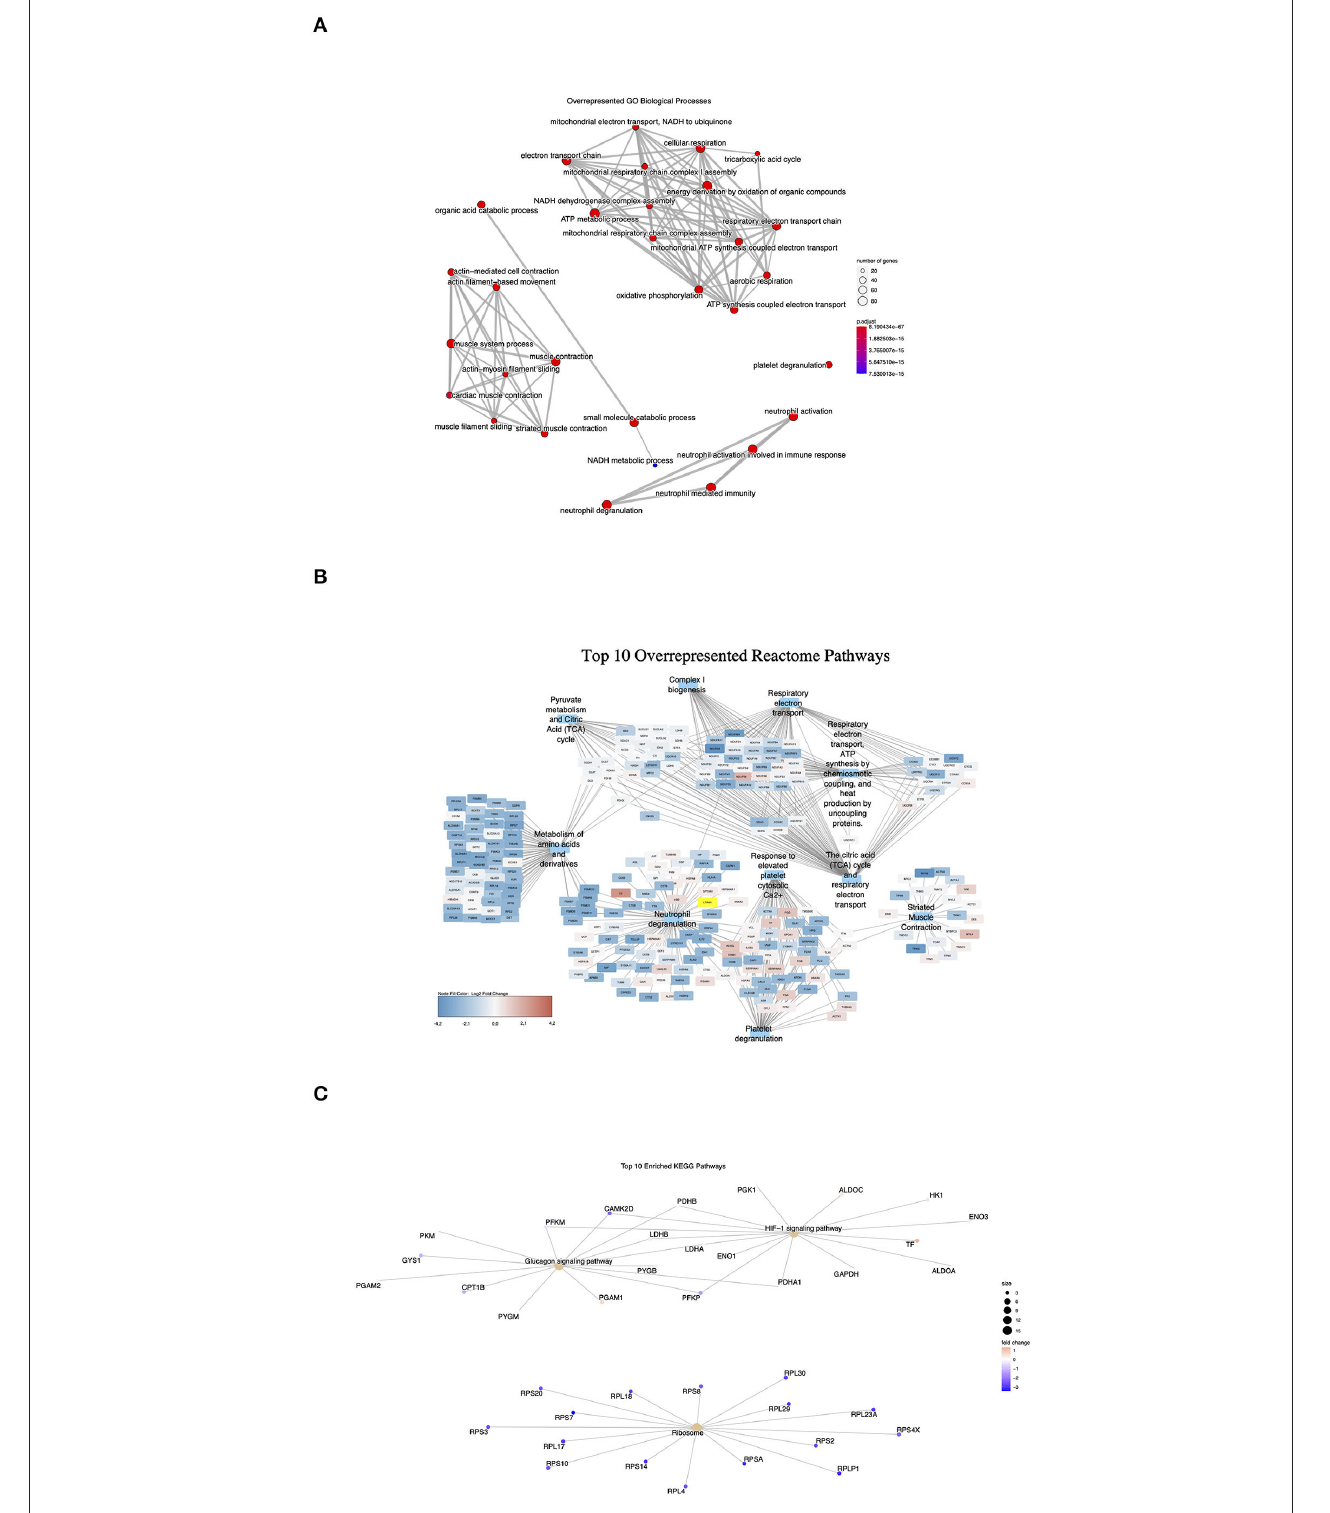
FIGURE 6 | Overrepresented signaling pathways in proteomics analysis. Dot size represents the number of protein encoding genes enriched in each pathway (IHD n = 6, Ctrl n = 5). (A) GO Biological processes. Adjusted p -value (p.adjust): red < purple < blue. (B) Top 10 Reactome pathways. (C) Enriched KEGG pathways. Red color represents upregulated protein levels. Purple and blue colors represent downregulated protein levels.